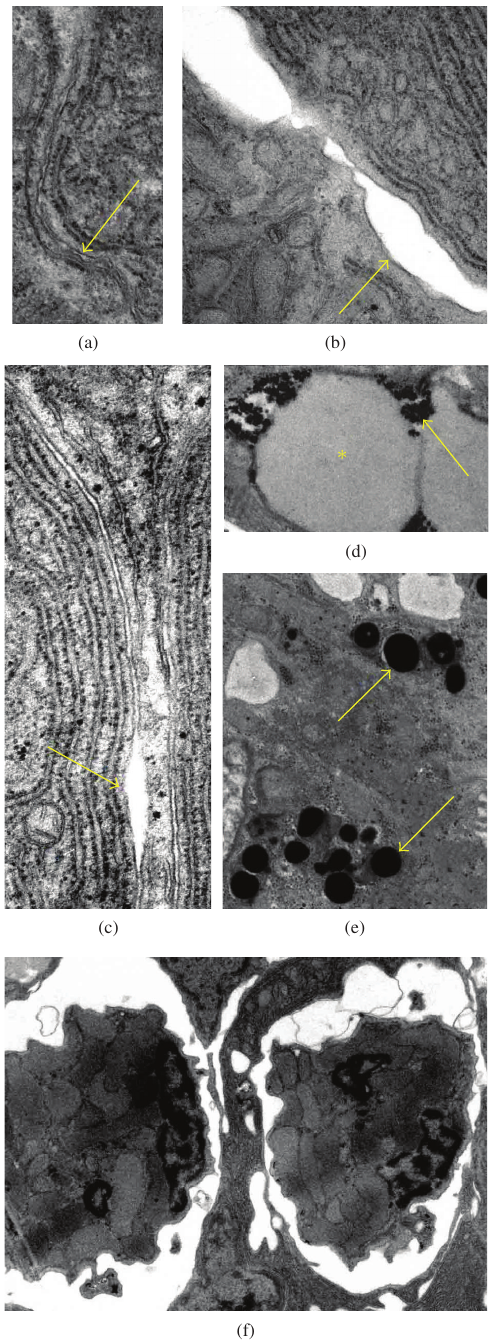
FIGURE 2: Ultrastructural changes in the hepatopancreas of B. aeruginosa exposed to the suspension of M. aeruginosa and mixed algae, respectively. (a) Cellular junctions of the control group (yellow arrow), 60000x. (b) The dilation of intercellular space in the cyanobacterial group at 10 days postexposure (yellow arrow), 60000x. (c) The recovery hepatocyte in the mixed group after 10 days of detoxification (yellow arrow), 60000x. (d) Lipids (yellow star) and glycogen (yellow arrow) of control snail, 50000x. (e) The presence of lipofuscins in the cyanobacterial group after the detoxification (yellow arrow), 15000x. (f) The presence of apoptotic body in the cyanobacterial group after the intoxication,